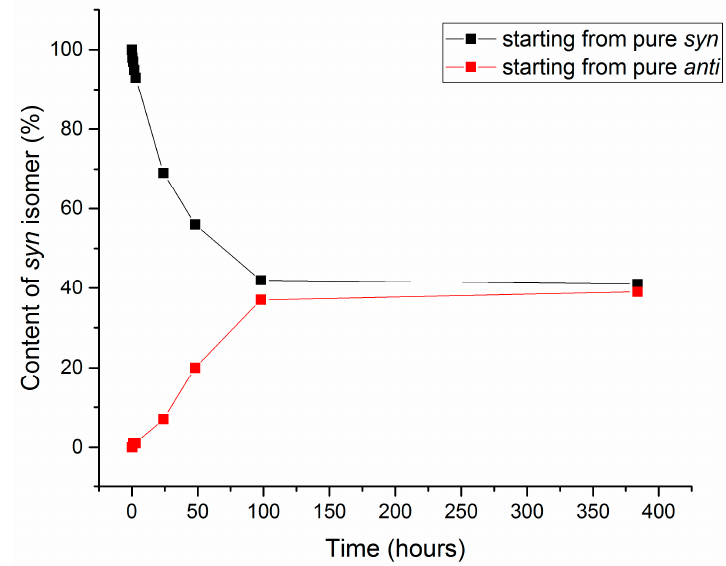
Figure 5. Amounts of syn oxime 1a during storage in DMSO containing 10 mol% p -TsOH starting from pure isomers (the content was determined from 1 H-NMR spectra presented in the ESI—Figure S9).